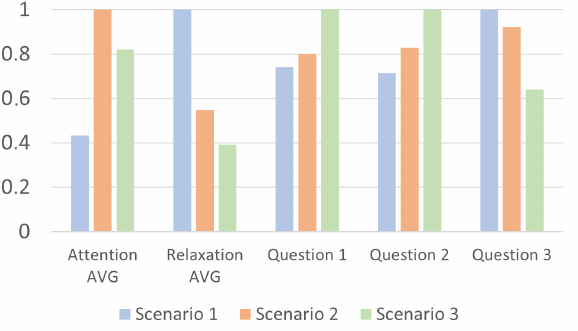
Figure 9. Normalized means from the conducted quantitative and qualitative research determined for the three tested